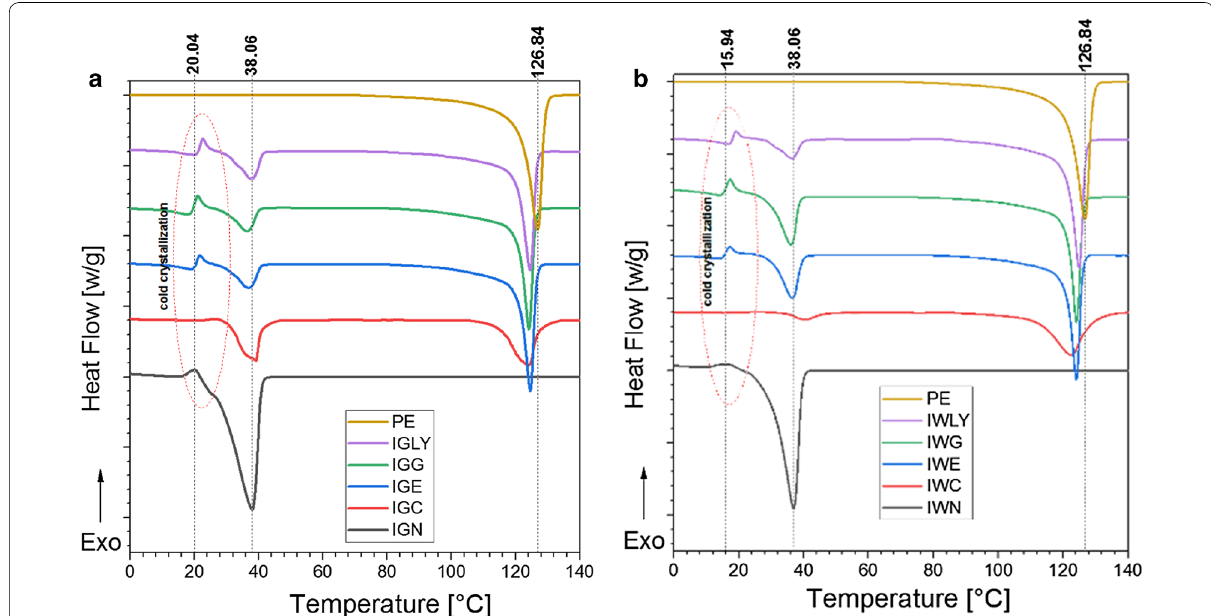
Fig. 5 DSC thermograms of Irvinga‑based adhesives (melting